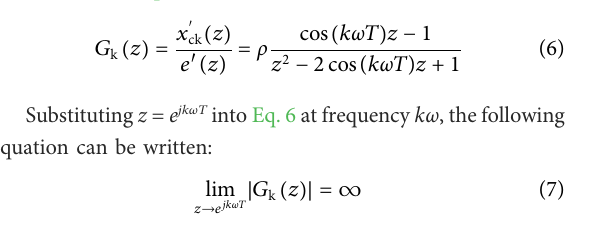
FIGURE 3 Corresponding harmonic observer in continuous domain of